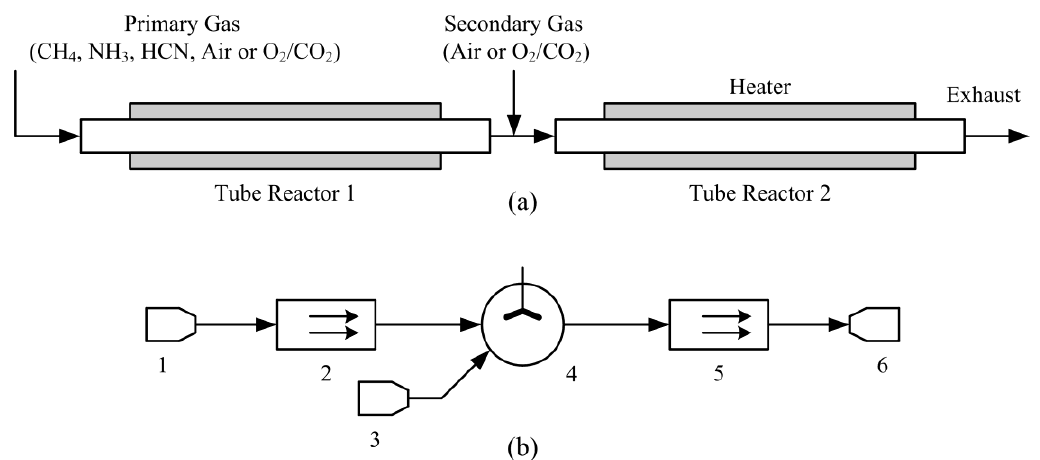
Figure 2. Schematic diagram of simulation object: ( a ) tube furnace of staged combustion; ( b ) reaction process modeling, 1 — external source of inlet gas ⅰ , 2 — plug flow reactor ⅰ , 3 — external source of inlet gas ⅱ , 4 — non-reactive gas mixer, 5 — plug flow reactor ⅱ , 6 — outlet flow of reactor.